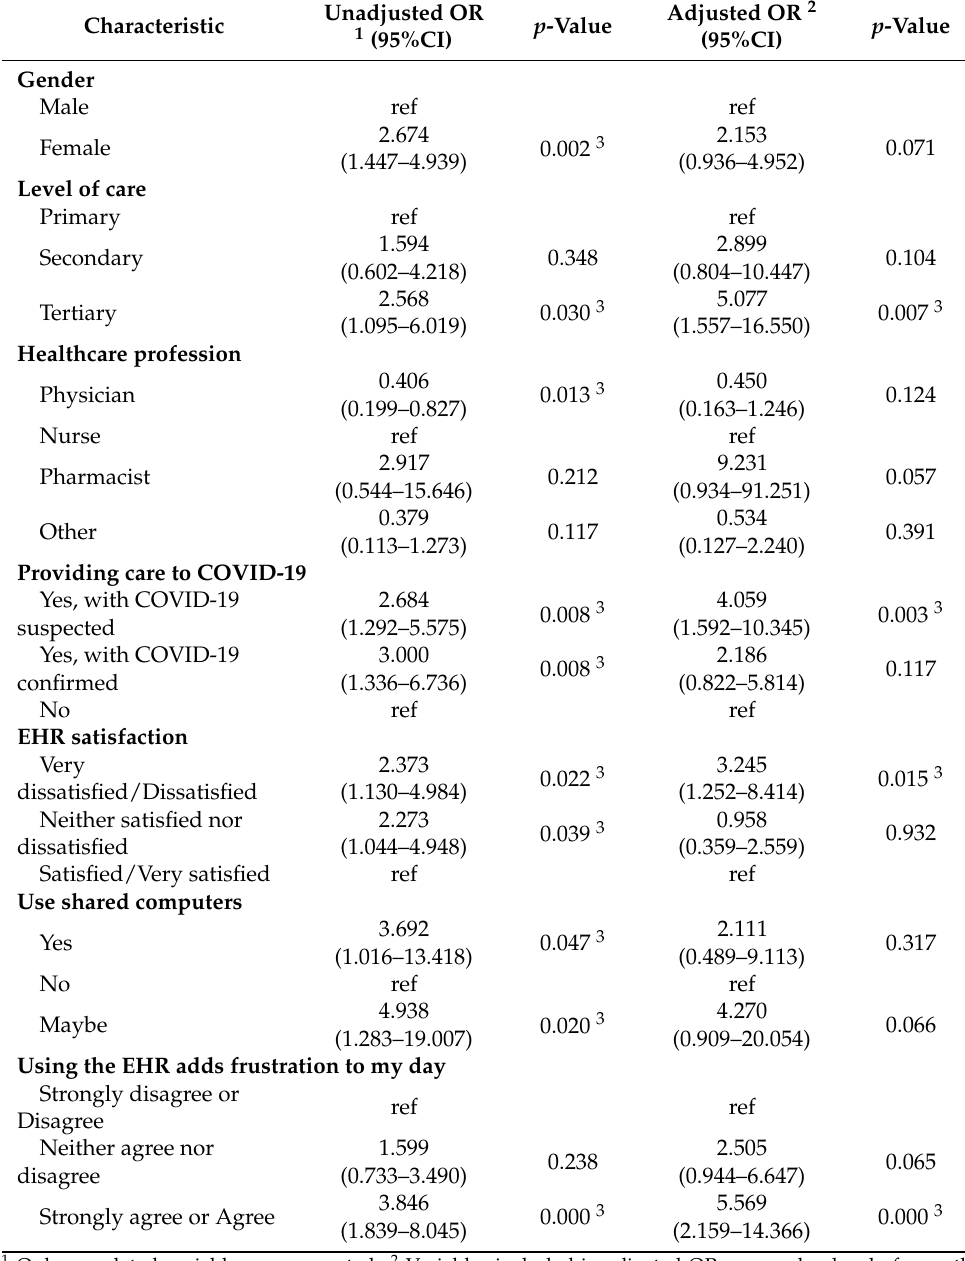
Table 4. Estimate of the association between demographic, professional, and HIT characteristics and burnout among participants (N =